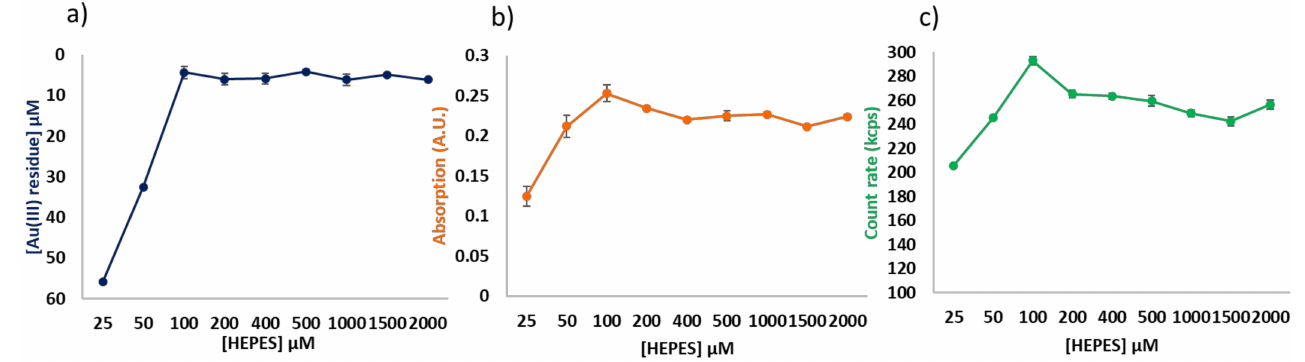
Figure 9. ( a ) The concentration of Au 3+ residue, ( b ) absorption of AuNPs, and ( c ) count rate of AuNPs from HAuCl 4 (100 µ M) with various concentrations of HEPES (25–2000 µ